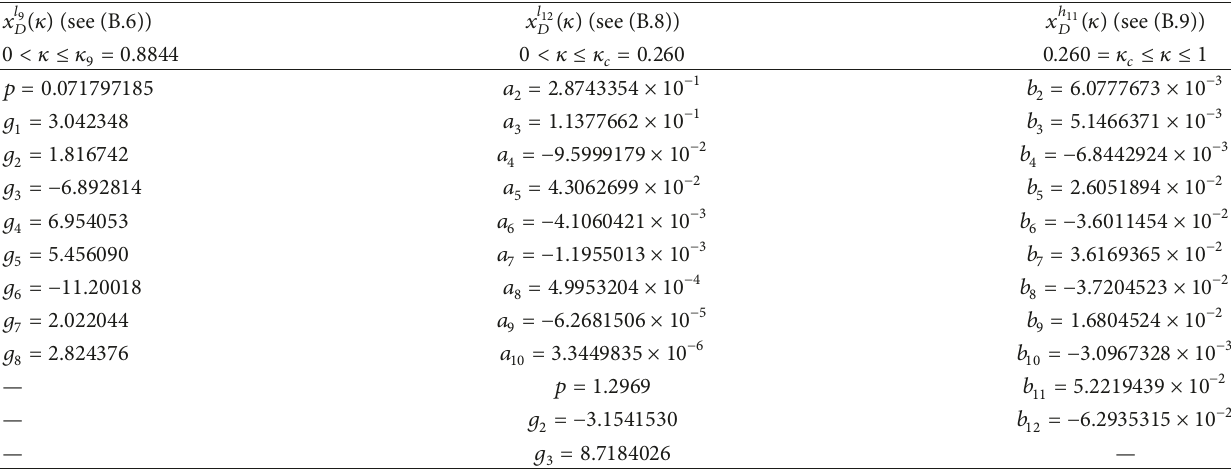
Table 8: Fitted values of the model-specific coefficients involved by the refined low-to-intermediate capacity 𝑥 𝐷 (𝜅) formula, 𝑥 𝑙 9 𝐷 (0 < 𝜅 ≤ 𝜅 9 ) (B.6), and for the couple of complementary high-accuracy low- and high-capacity Debye temperature formulas, 𝑥 𝑙 12 𝐷 (0 < 𝜅 ≤ 𝜅 𝑐 ) (B.8) and 𝑥 ℎ 11 𝐷 (𝜅 𝑐 ≤ 𝜅 ≤ 1) (B.9), which have been determined by least-mean-square fittings of a sufficiently comprehensive set of couples of high-accuracy 𝜅 versus 𝑥 𝐷 curve points (in accordance with Table 7). 𝑥 𝑙 9 (𝜅) (see (B.6)) 𝑥 𝑙 12 𝐷